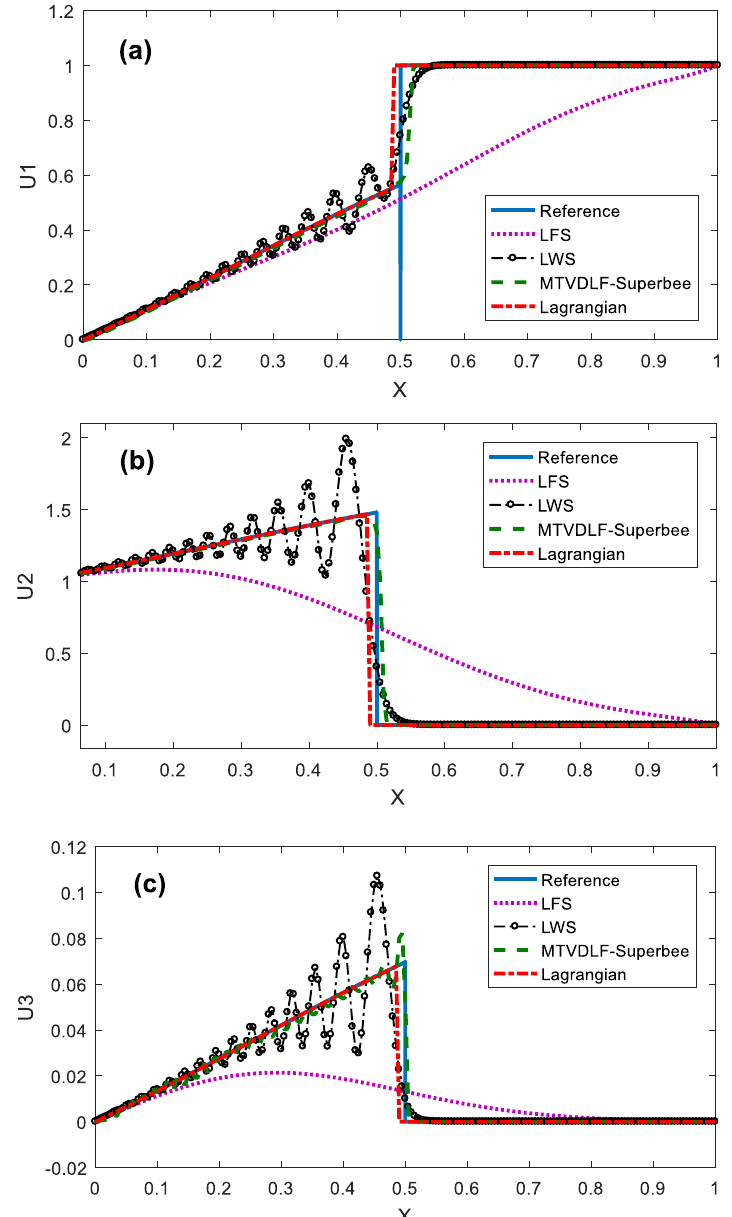
Figure 3. Comparisons of numerical methods for autocatalytic reaction model with three-component reactants at t = 0.5. Concentration distribution along the reactor for ( a ) species A ( b ) species B and ( c ) species C.